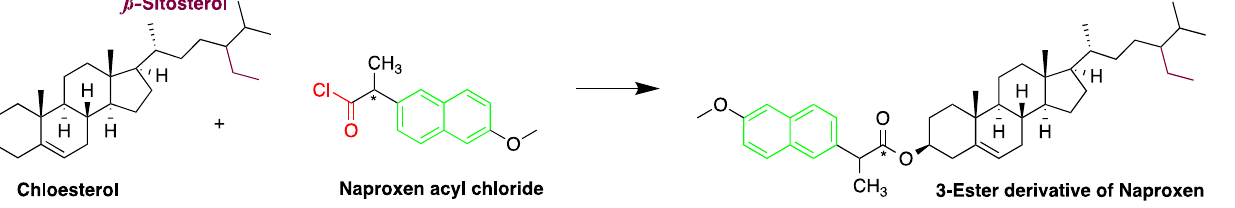
Figure 10. Derivatization of cholesterol by naproxen acyl chloride. Free 7 α -hydroxycholesterol (7-HC) levels in human serum were reported to be a good indicator for bile acid synthesis. An HPLC-FLD method was developed by Saisho et al. to quantify 7-HC levels in dog plasma, with the purpose of studying the effect of cho- lestyramine on plasma levels of 7-HC. 7-HC was converted to its fluorescence derivative, by two procedures, after being extracted and then purified [57]. The two derivatization reagents used were 1-AN and 7-methoxycoumarin-3-carbonyl azide (MC-CON 3 ). The MC-CON 3 derivatization resulted in higher fluorescence intensity compared to 1-AN route. 1-AN produced only a C-3 fluorescent derivative due to the bulky anthracene group and steric hindrance around the C-7 position. In comparison, MC-CON 3 yielded a double coumarin derivative at the C-3 and C-7 positions (Figure 11) producing a LOD of 4 pg (S/N = 5).